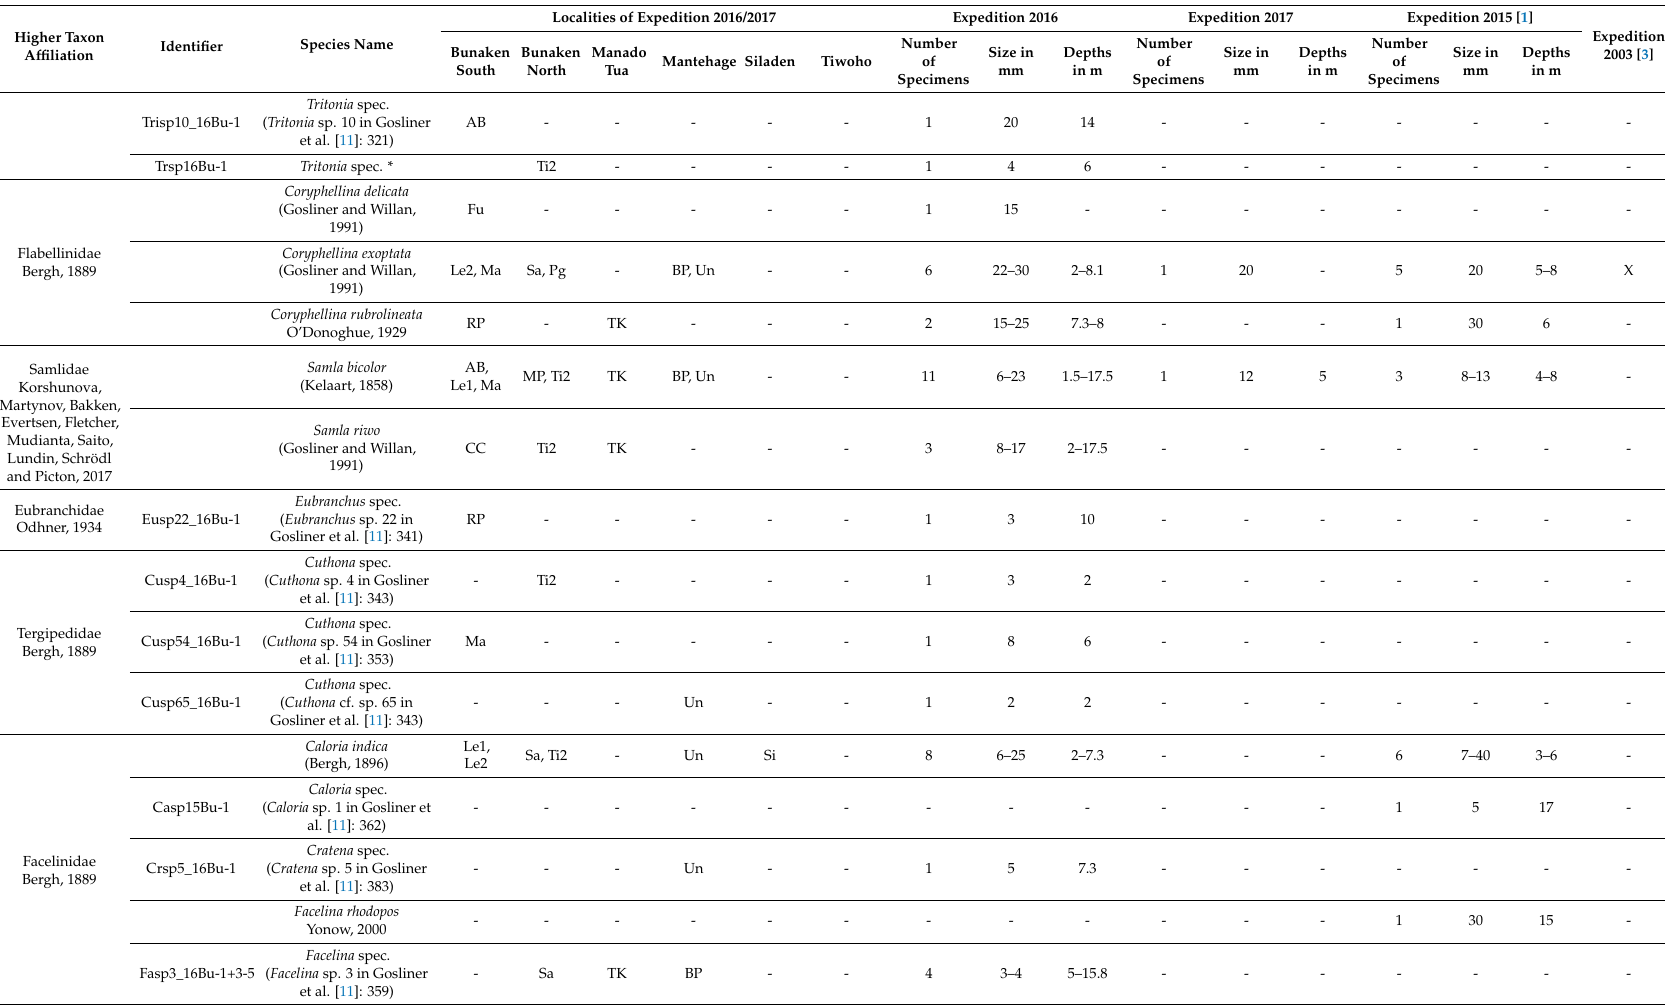
Cuthona spec. ( Cuthona cf. sp. 65in Goslineretal. [11]: